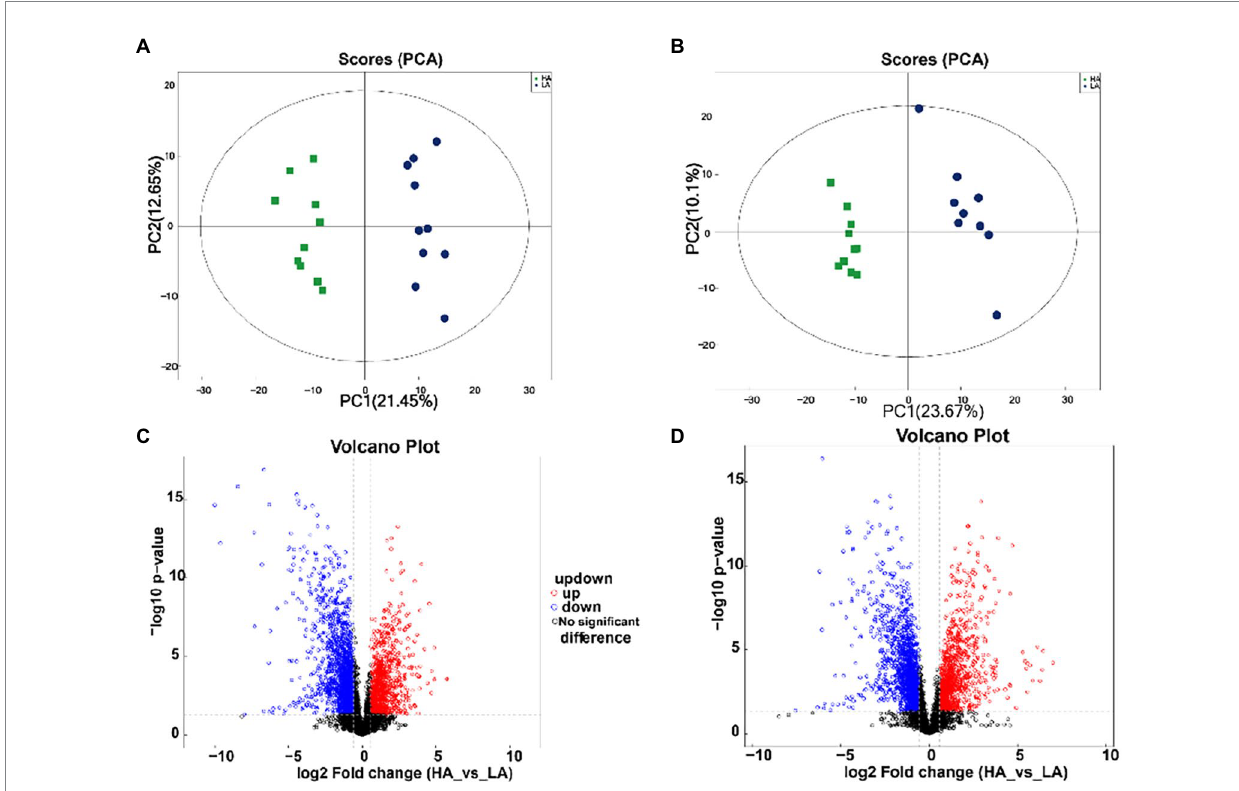
FIGURE 3 Metabolomic profiling of fecal samples. Scatter plots of the principal coordinate analysis model based on all identified metabolite features of gut samples from the two groups. [ (A) positive mode; (B) negative mode]. The volcano plot of the comparison between the low-altitude (LA) and high- altitude (HA) groups [ (C) , positive mode, (D) , negative